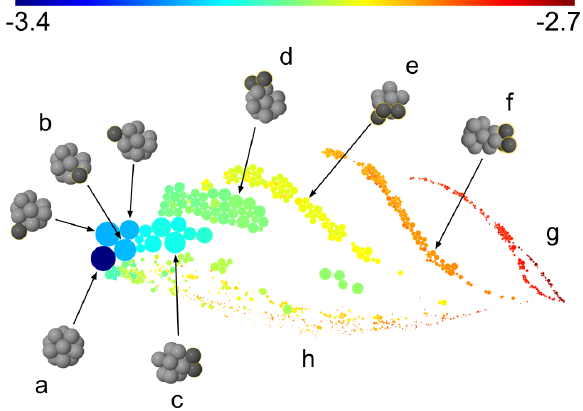
FIG. 2. Labeled 2D SHEAP map produced from a set of 1108 distinct minima on the LJ 13 PES, located with RSS, described by sorted lists of all pairwise distances. The projection uses a perplexity of 30, with a minimum sphere radius R 0 ¼ 0 . 005 . The circles representing each structure are colored according to energy per atom in Lennard-Jones units; see the color bar at the top of the figure. Basin volumes are represented by the area of each circle. (a) – (g) denote clusters of structures of similar energy and configuration; representative structures from each are shown. Structures in (h) are less obviously clustered and tend to be comprised of less-ordered packings of atoms.